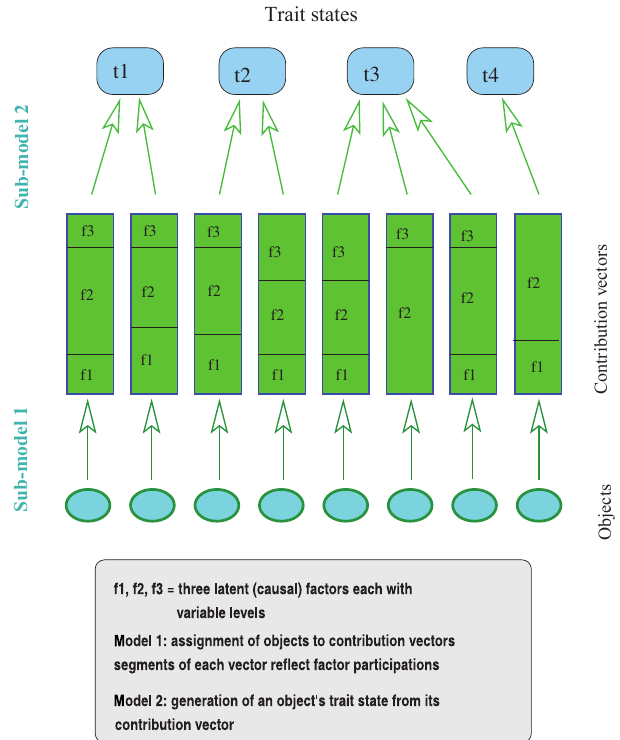
Figure 1. Illustration of the constituents involved in modeling the effect of latent factors on the trait expressions of a set of objects (note that assignment of two objects to the same contribution vector is not required to always generate the same trait state – as illustrated for the middle two